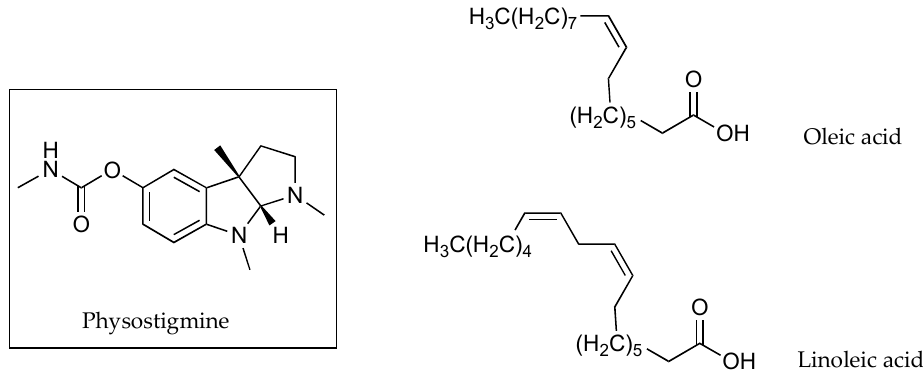
Figure 10. Physostigmine and counter ions OA and LA.